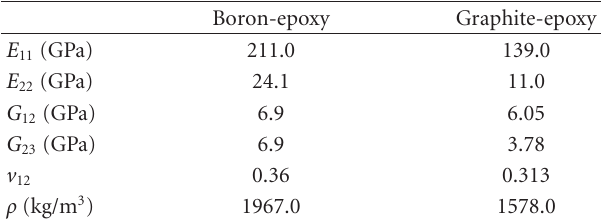
Table 1: Properties of composite materials